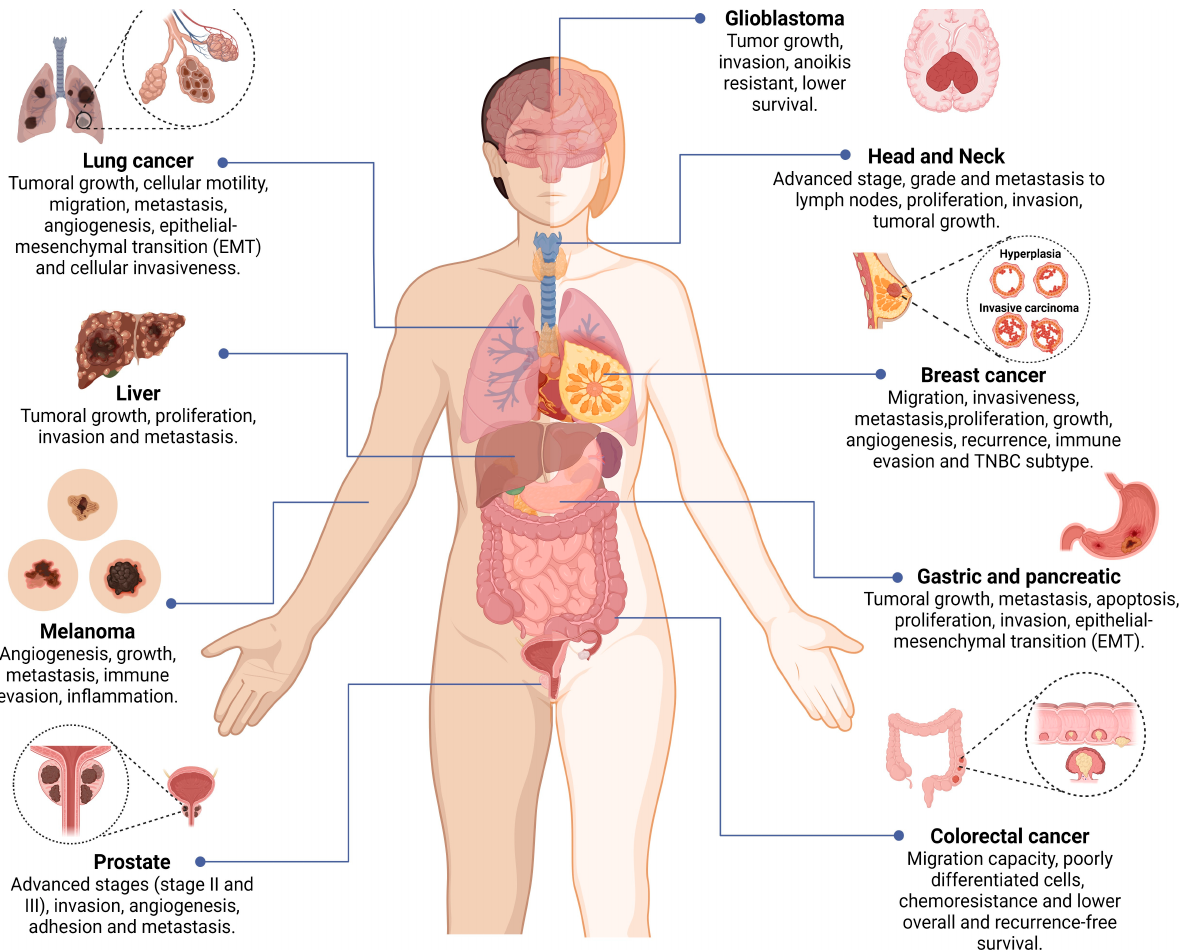
Figure 4. Role of syntenin-1 in the development of different types of cancer. The overexpression of syntenin-1 has been associated with the progression of several cancers by promoting tumor growth, migration, invasion, immune response evasion, proliferation, angiogenesis, and metastasis. Additionally, it has been associated with advanced stages, overall survival, and recurrence. Tumors with an overexpression of syntenin-1 include melanoma, prostate, colorectal, and breast cancer, followed by glioblastoma, gastric, pancreatic, liver, and HNSCC. Image created in BioRender (www.biorender.com, accessed on 14 February 2023).